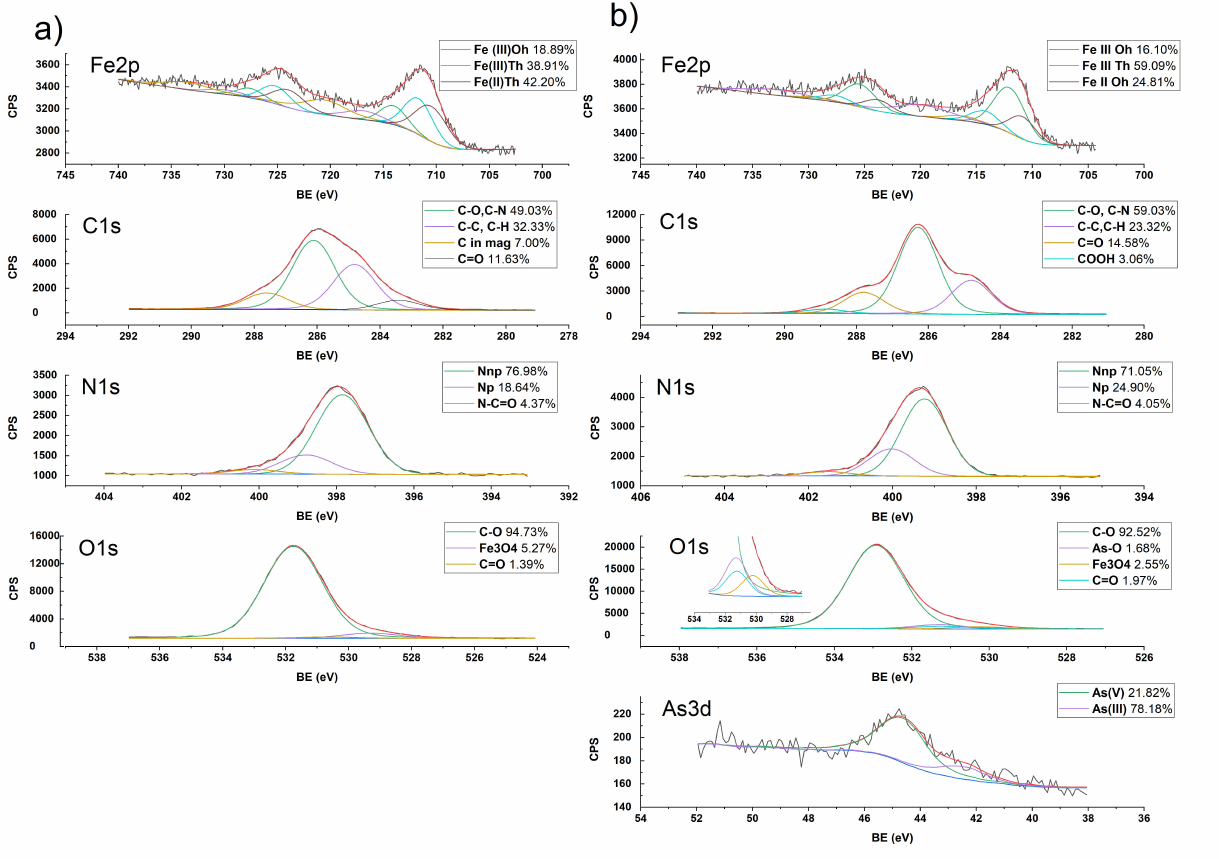
Figure 3. XPS spectra of ( a ) ChM and ( b )